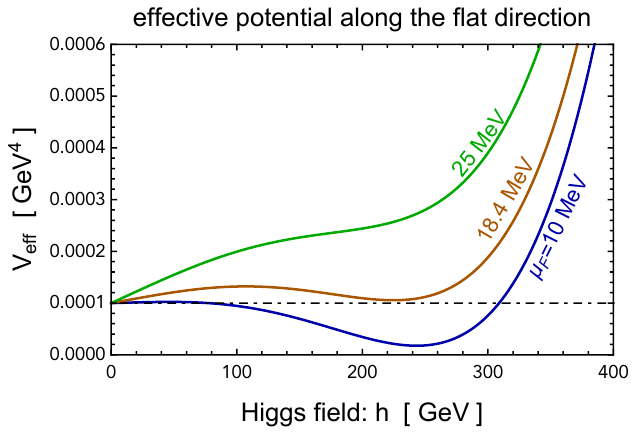
Figure 8 . The e(cid:11)ective potential in (A.1) for di(cid:11)erent values of Fermi-momentum, (cid:22) F . The numerical values of the model parameters are the same as in eq.